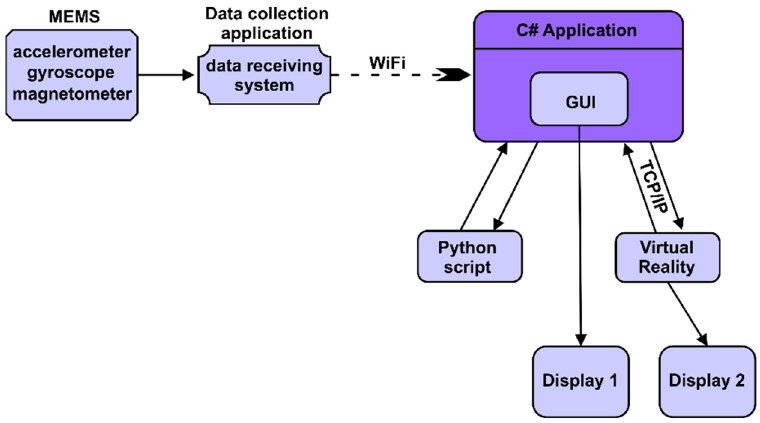
Figure 6. Interconnection of components.